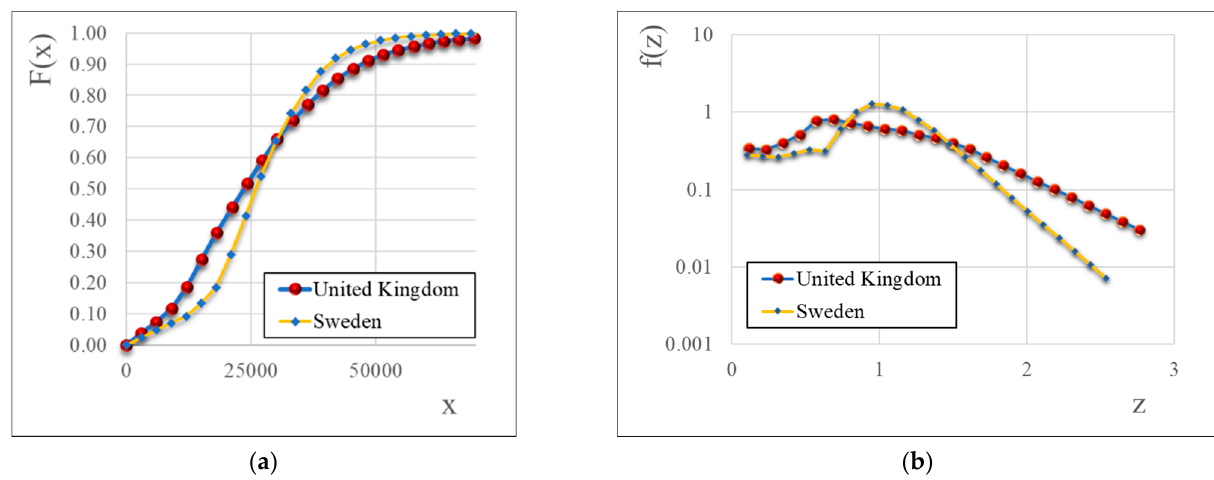
Figure 14. 1991 Share of income in Sweden and the United Kingdom. ( a ) Distribution function. ( b ) Probability density function of the standardized income.